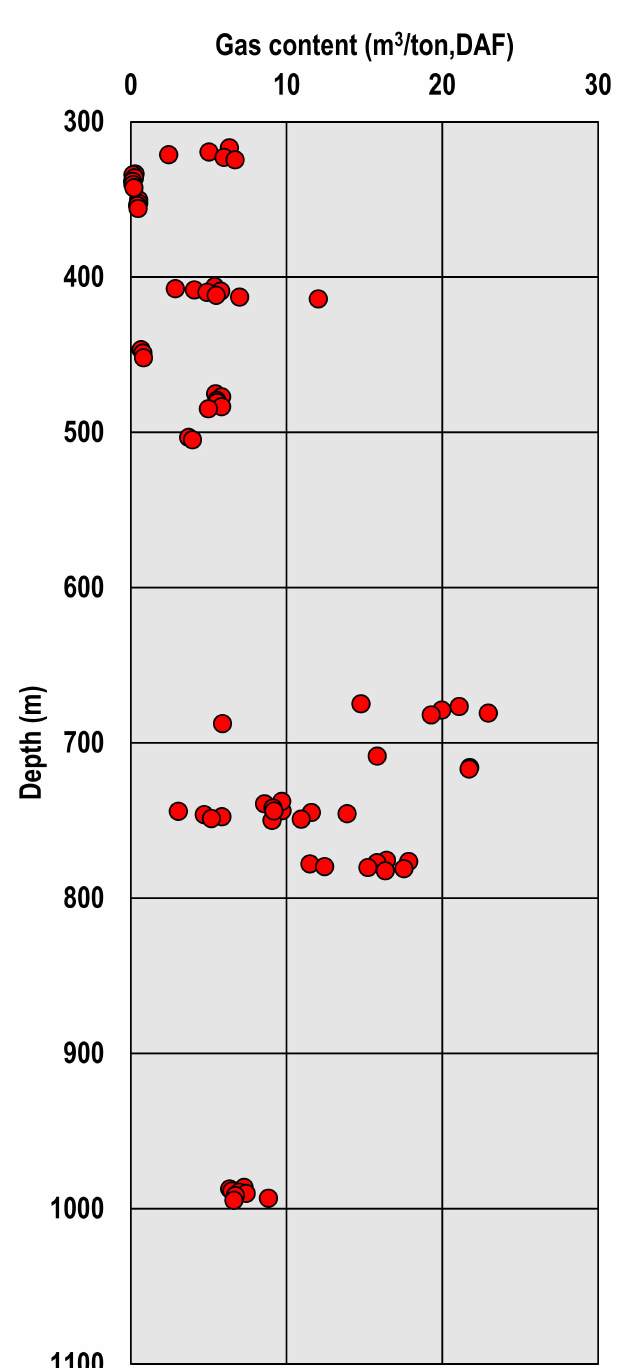
Figure 13. Gas content versus depth for the Hosskisons coal in the Gunnedah Basin. Significant variability in gas content is observed [81] (This figure was originally published in The International Journal of Coal Geology Volume 165 Pages